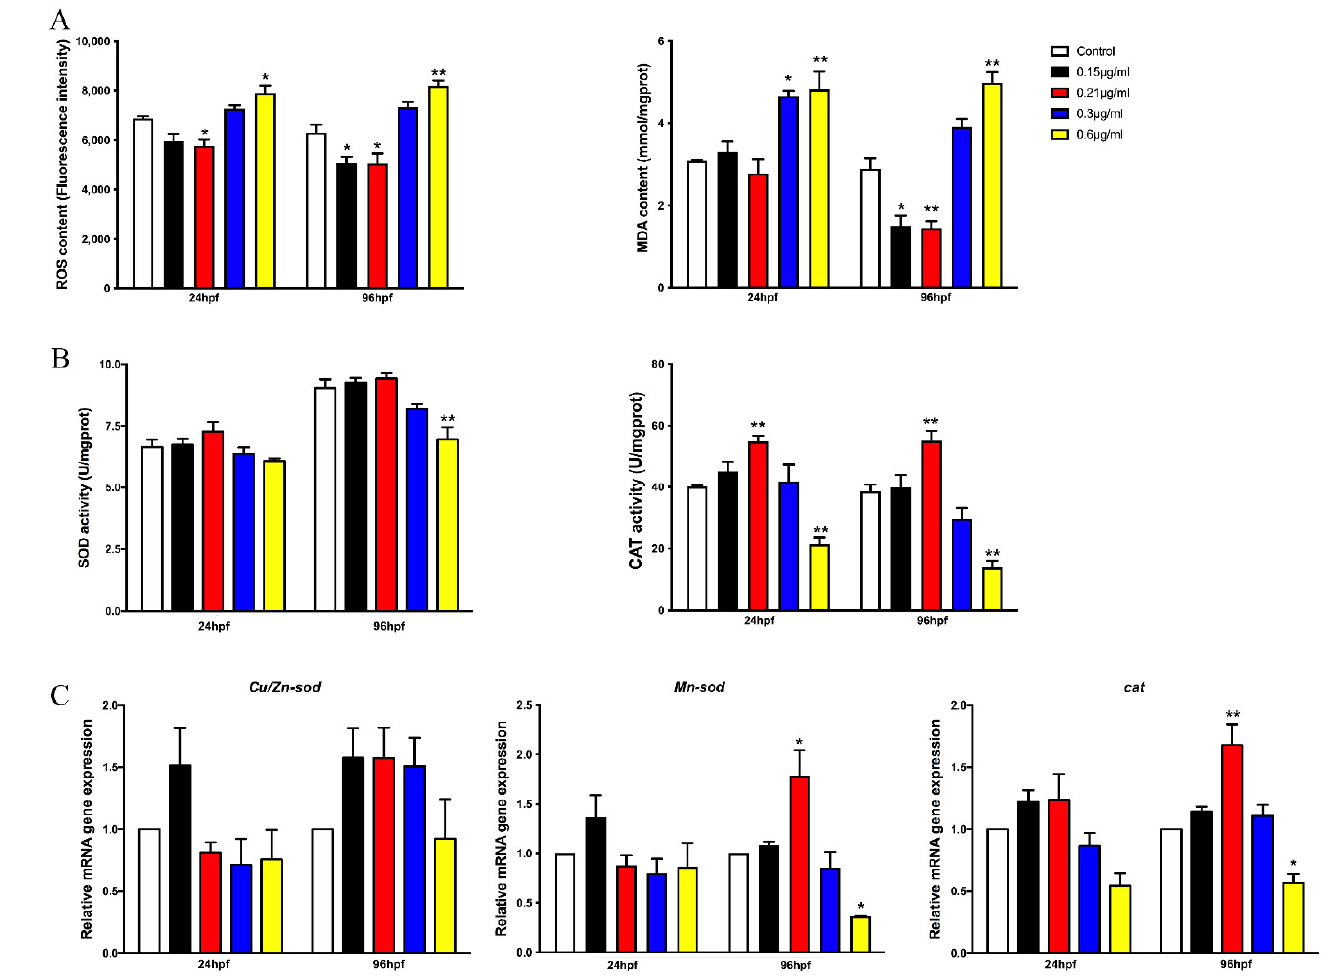
Figure 3. Measurement of the effect of the honokiol microemulsion on oxidative stress in zebrafish embryos. The content of oxidation products is shown in ( A ). The antioxidant activity is shown in ( B ). The mRNA expression of oxidative genes is shown in ( C ). The data are expressed as the mean ± SD (* p < 0.05, ** p < 0.01 compared with the control